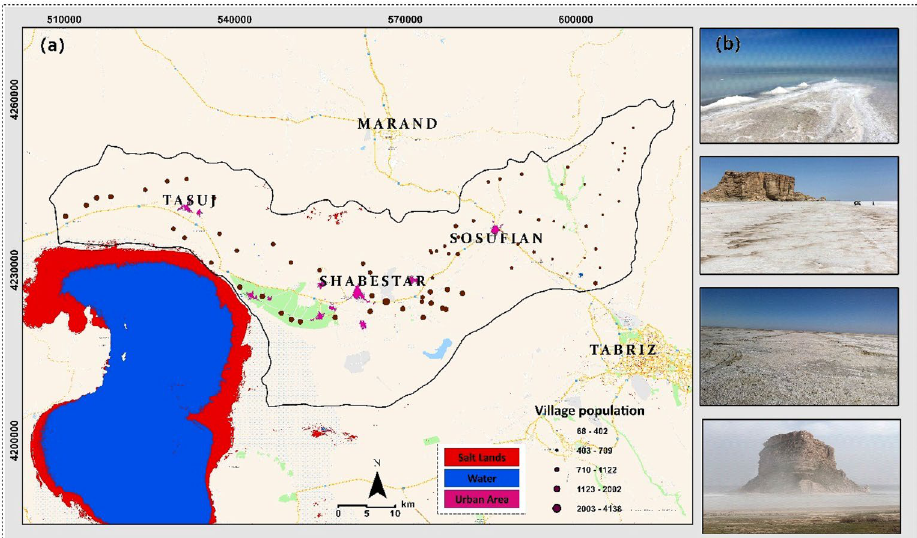
Figure 1. Location of the study area north of Lake Urmia ( a ), and several examples of salt-dust sources around the lake ( b ). The map is created in ESRI- Arc GIS version 10.7 under licenses of Humboldt-Universität zu Berlin (https:// deskt op. arcgis. com/).